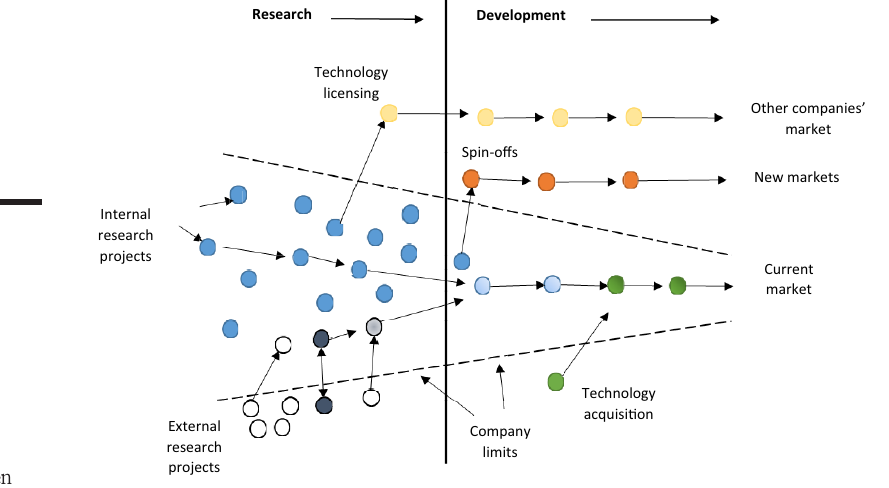
Figure 1. The model of